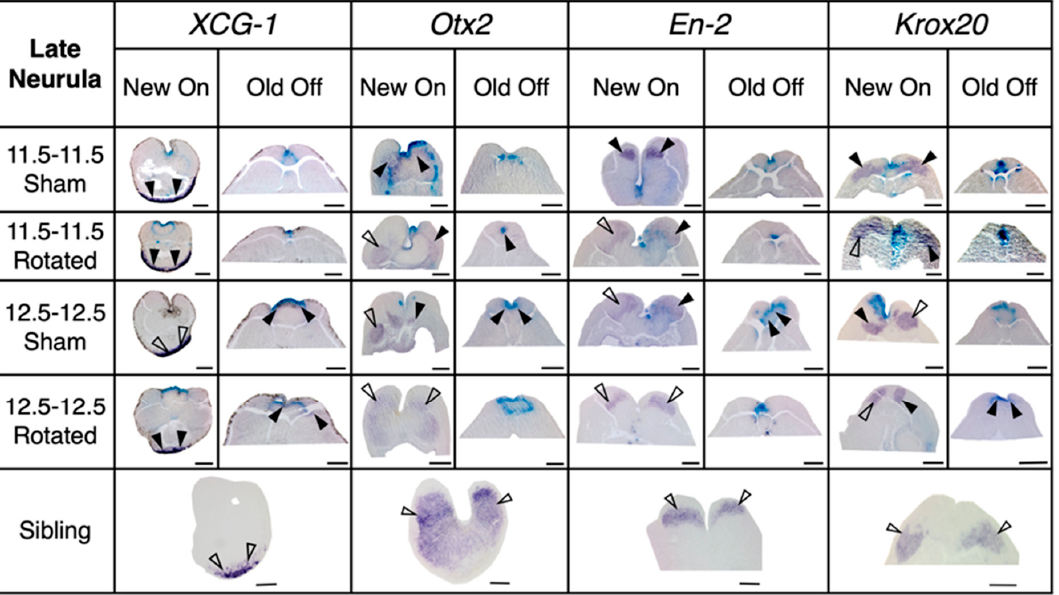
Figure 5. Representative examples of expression of regional marker genes in transplants and sibling controls at late neurula stage (St. 18). With a lateral view with dorsal facing up for XCG-1 and Otx2 , and dorsal view for En-2 and Krox20 , anterior is to the right in all images. Purple stain marked with a solid arrowhead indicates gene expression and aqua blue stain was used to indicate transplant incorporation. Scale bar represents 1 mm.